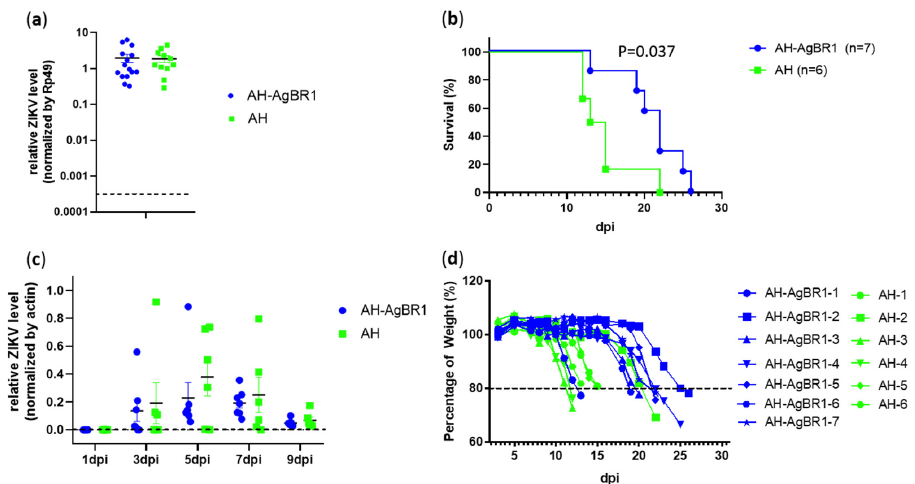
Figure 3. Active immunization in AgBR1 AG129 mice with AH-AgBR1 against mosquito-borne ZIKV infection. Survival rates, viremia, and body weight were analyzed in immunized AG129 mice after ZIKV infection. ( a ) The ZIKV viral load recovered from the thorax of ZIKV-infected A. aegypti mosquitoes after mice challenge. The basal line corresponds with the background observed in non-infected mosquitoes. ZIKV RNA levels were analyzed by qRT-PCR and normalized to the levels of Rp49 . Each dot represents one mosquito. ( b ) The survival rates of AH-AgBR1 and AH mice after a mosquito-borne ZIKV challenge. The mice were observed every 24 h for 30 days. ( c ) The ZIKV viral load recovered from the blood of AH-AgBR1 and AH-immunized mice after challenge measured by qRT-PCR. Each point represents an individual animal. The relative ZIKV level was normalized to mouse β actin RNA levels. ( d ) The body weight loss (%) of mice after challenge. The error bars represent mean ± SEM. Asterisks represent significant difference between samples (AH-AgBR1 versus AH) for each analyzed day, calculated by Mann–Whitney non-parametric test ( p ≤ 0.05). Survival statistical analysis was calculated by Log-Rank test ( p ≤ 0.05). (Three separate experiments were operated biologically independently with the same results.) Table 1. AgBR1 antibody titers and the date of death post ZIKV infection, shown individually. Mouse